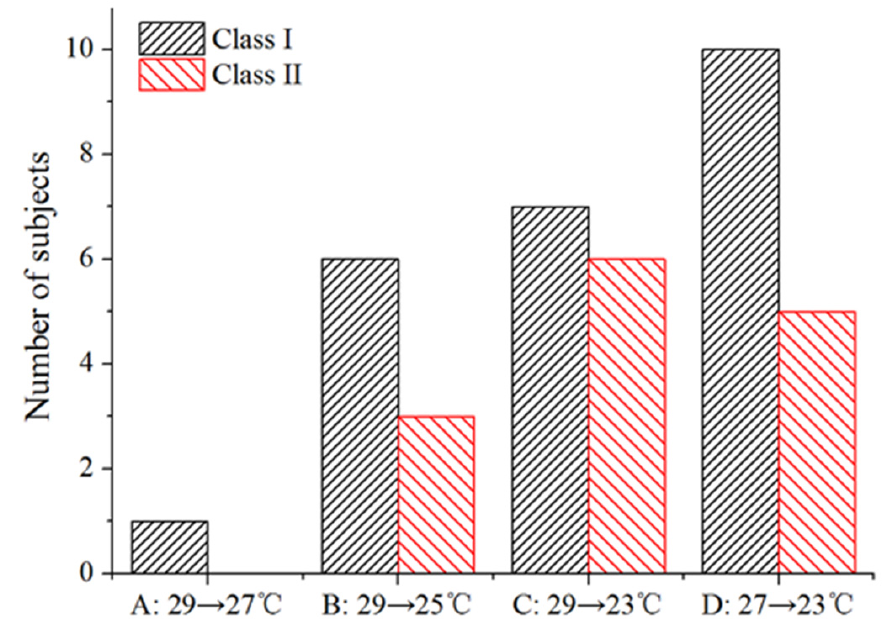
Figure 9. Number of participants who have the intention to turn off the air conditioning and their TSV when the air conditioning off behavior intention occurred after T = 30 in four scenarios (Class I: intent of turning off air conditioning occurred when TSV = − 1, Class II: intent of turning off air conditioning occurred when TSV = − 2).